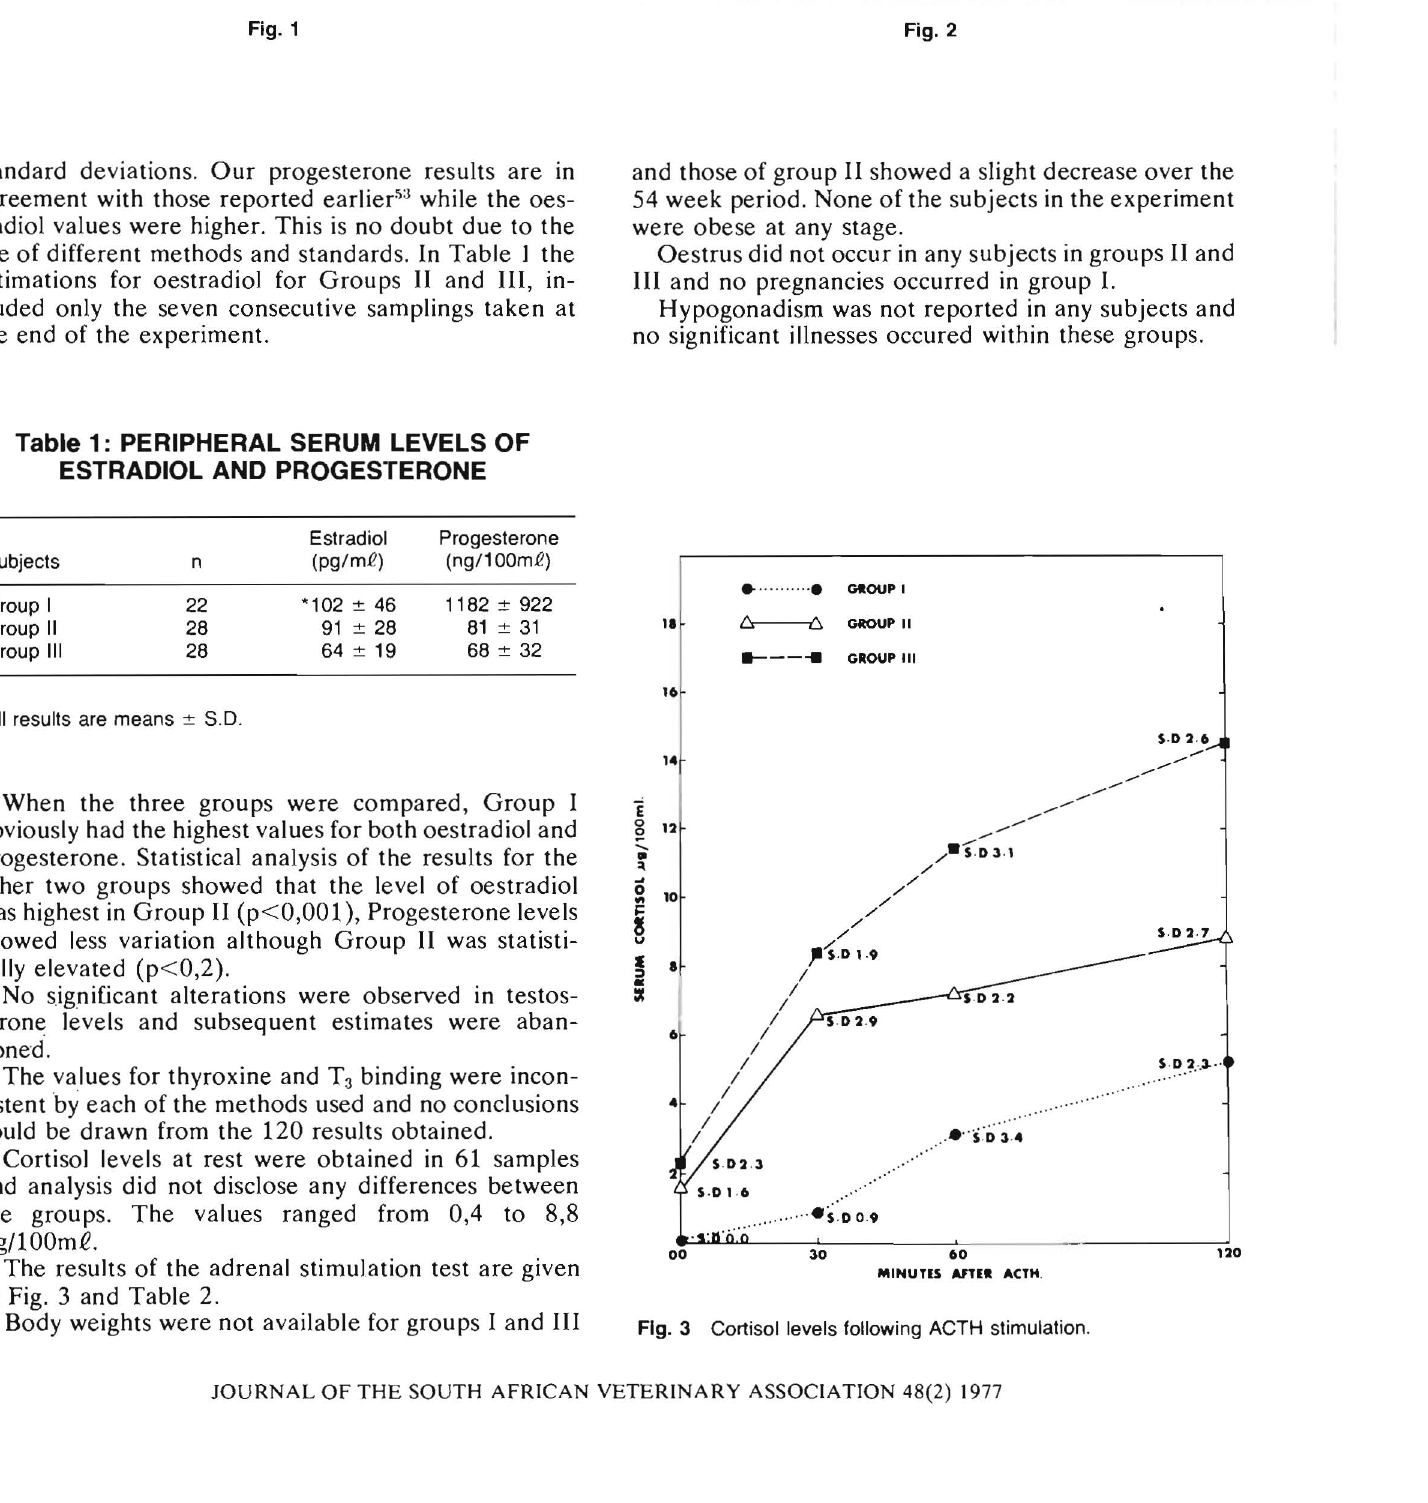
Fig. 3 Cortisol levels following ACTH